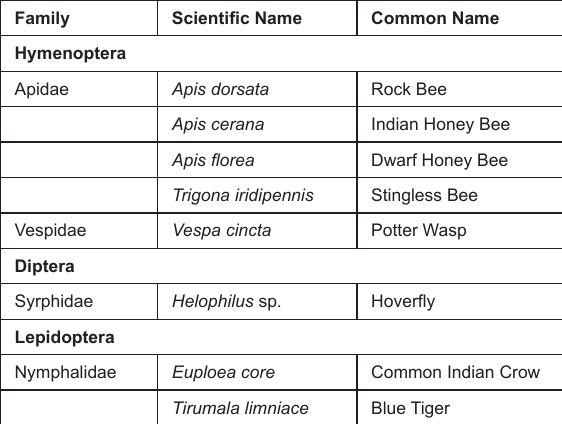
Table 1. List of insect foragers on Shorea